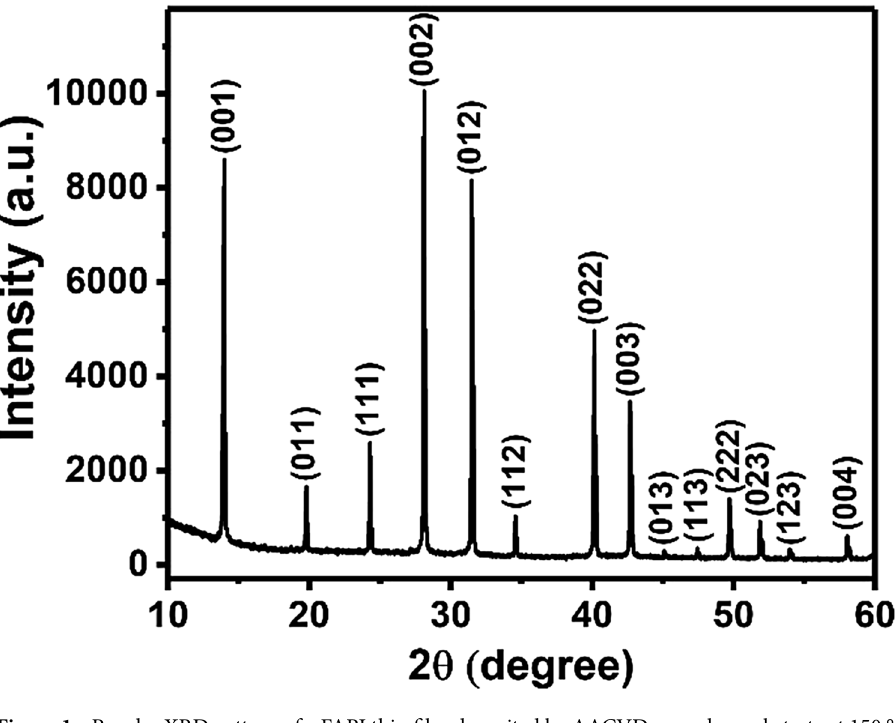
Figure 1. Powder XRD pattern of a FAPI thin film deposited by AACVD on a glass substrate at 150 °C.